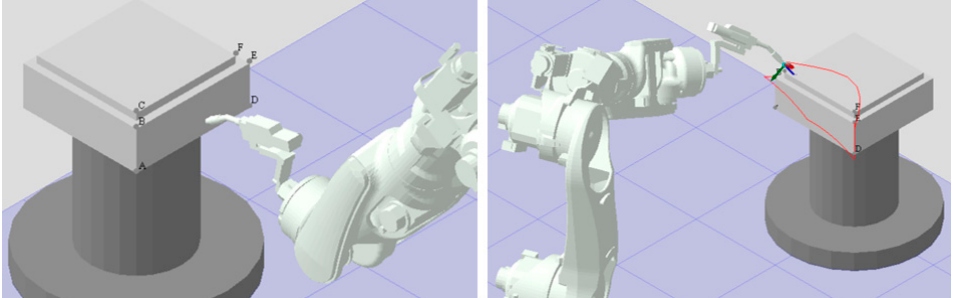
Figure 3. Model of the developed workstation and movements analysis. Table 2. Times of individual movements of the robot.